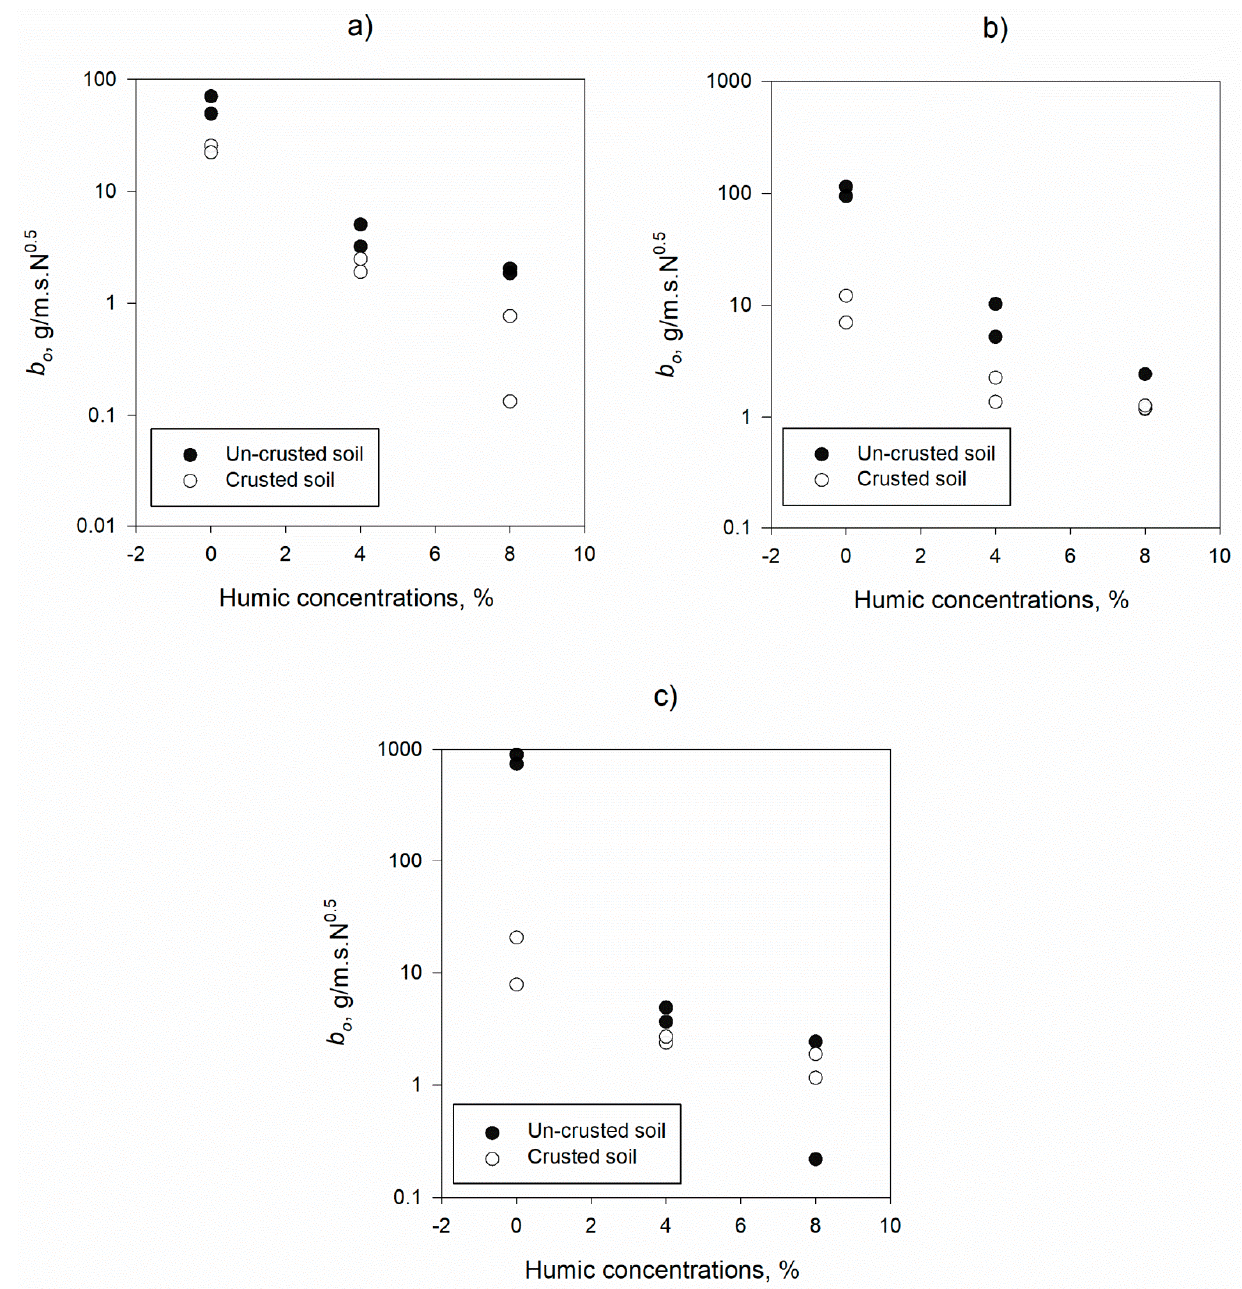
Figure 5. The influence of humic acid concentrations of 0%, 4%, and 8% on the dimensional soil detachment parameter ( b 0 ) of the Wilson model derived from the JET instrument achieved on soil specimens of crusted and uncrusted soils for curing times of: ( a ) one week, ( b ) two weeks, and ( c ) three weeks. Note that each test was replicated.